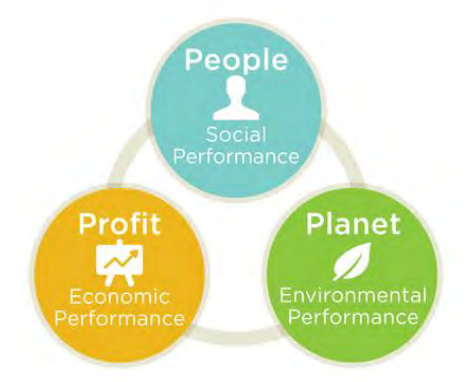
Figure 1. Triple bottom line (Planeta, 2005, in Böhm,